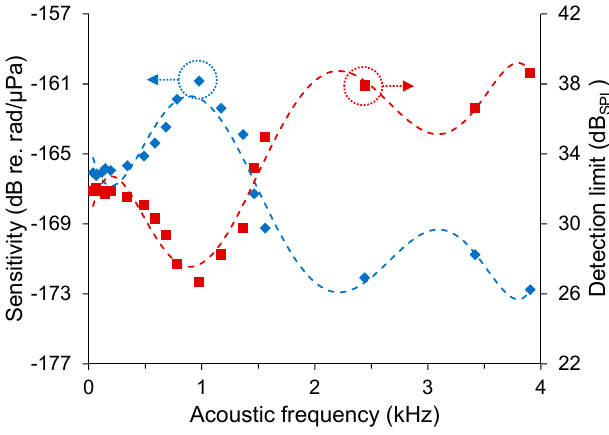
Figure 18. Measured frequency-resolved and sensitivities and detection limits, with polynomial fits. To increase the sensitivity, a longer OM and shorter wavelength must be used. The limiting factor is the maximum length of OM that can be fabricated. A mandrel of lower Young’s modulus and lower Poisson ratio would also be preferable. Moreover, the wall thickness of the mandrel and